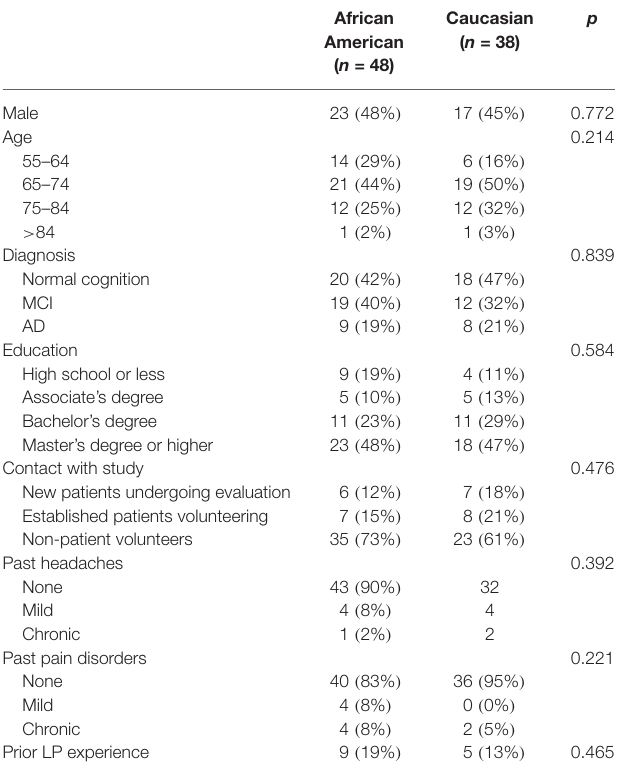
TABLE 2 | Demographic information for LP survey respondents.